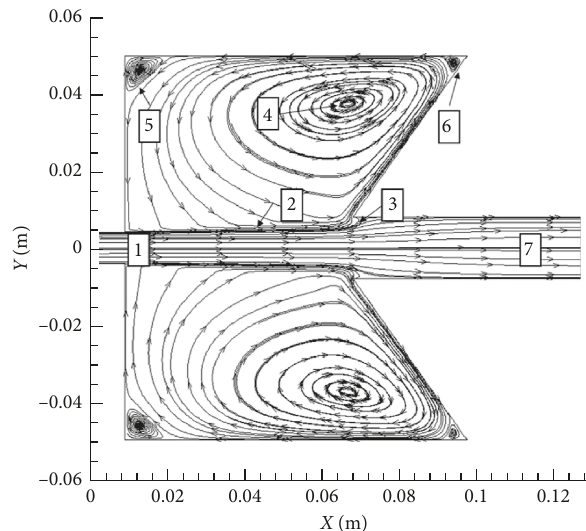
Figure 6: Time-averaged vorticity partitioning in cavitation jet nozzle.